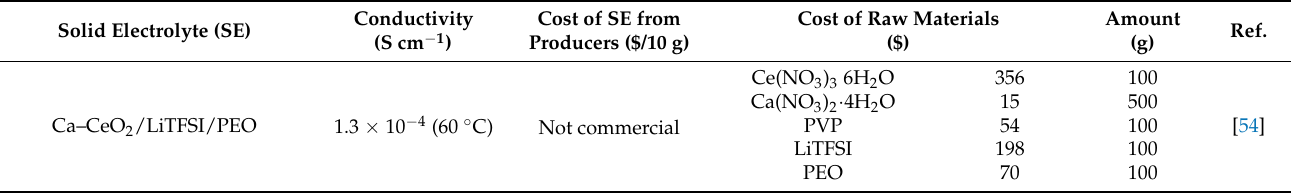
Table 3. Ionic conductivities and costs of different types of solid electrolytes (For the solid polymer electrolytes (SPEs), only the cost of starting raw materials is given since they are not commercialized yet. The prices for inorganic solid electrolytes are received from different suppliers, and the average values are